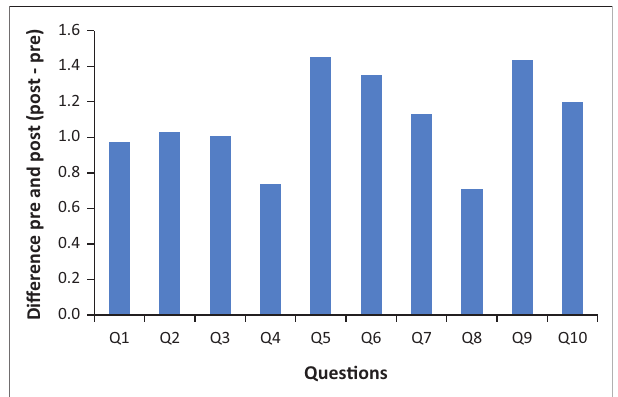
FIGURE 2: Differences between pre- and post-items for the 10-item evaluation